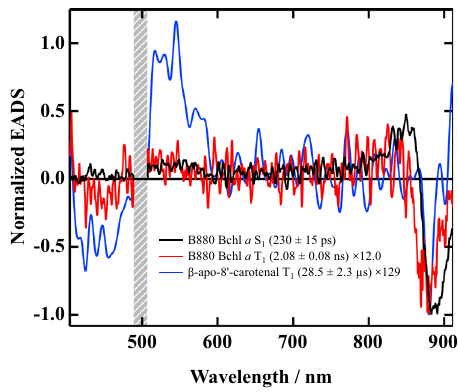
Fig. 9 EADS obtained by the global analysis against the entire observed dataset of sub-nanosecond time-resolved absorption spectra of Re β apo. EADS obtained by the global analysis against the entire observed dataset of nanosecond time-resolved absorption spectra of Re β apo based on a 3-components sequential model are shown. The hatched bar at 500 nm shows the region of pump laser light. The spectra were truncated at this pump laser spectral region to reduce the effect of the pump light